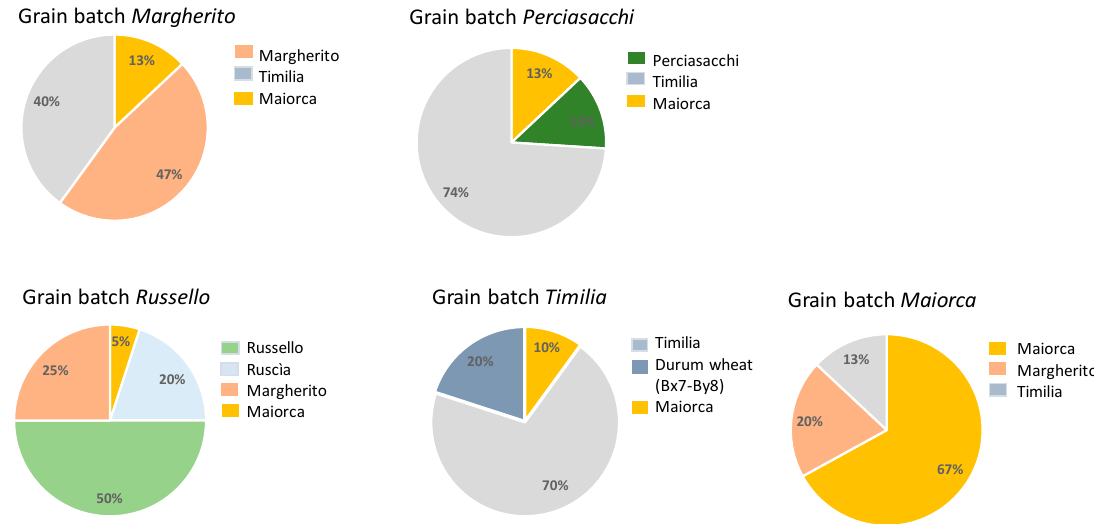
Figure 4. Percentages of contamination found in the different grain batches of three durum wheat Sicilian landraces (Per- ciasacchi, Russello, Timilia), one historical durum wheat variety (Margherito) and one bread wheat Sicilian landrace (Ma- iorca).